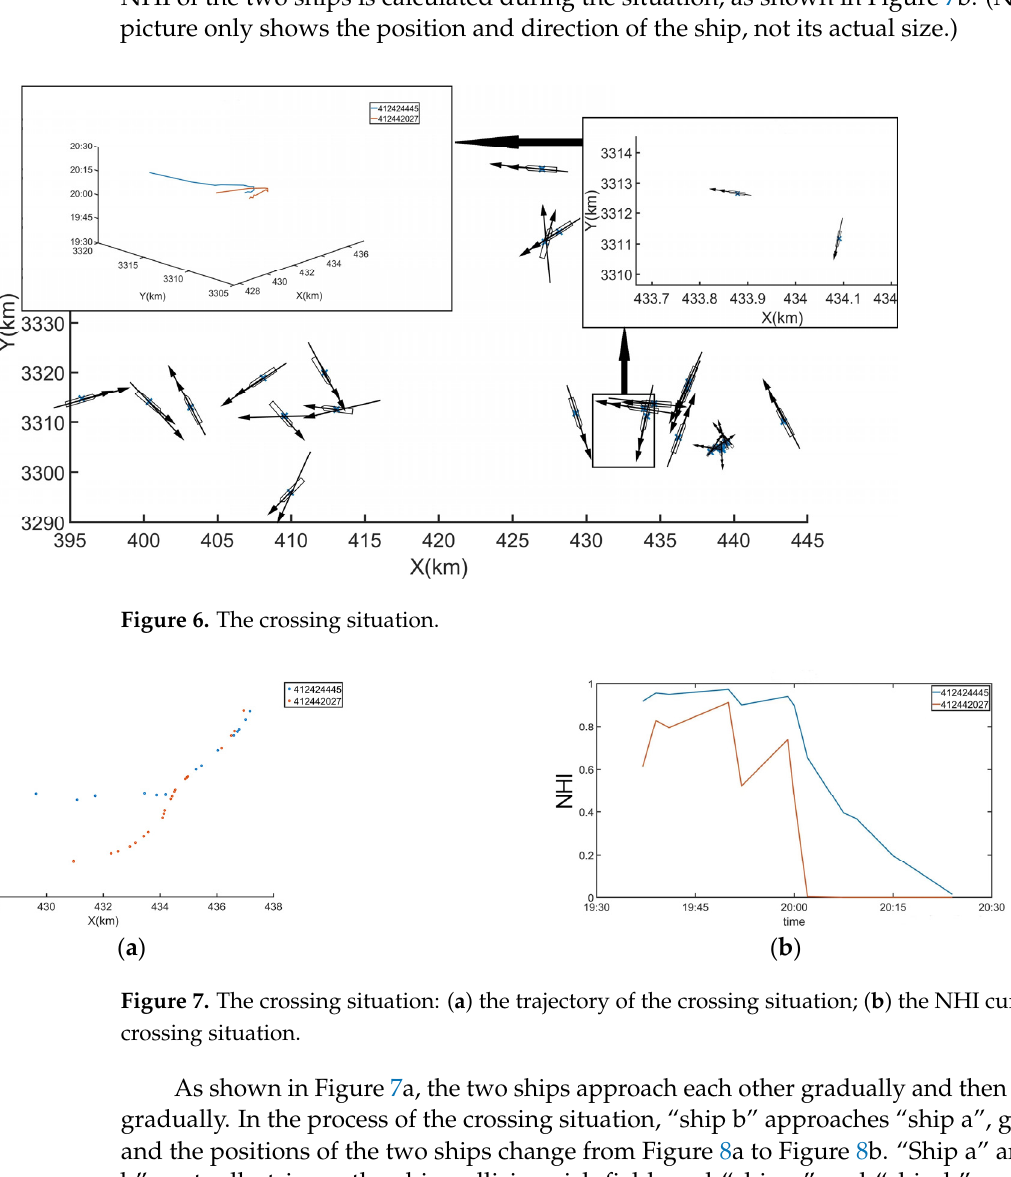
( b ) Figure 7. The crossing situation: ( a ) the trajectory of the crossing situation; ( b ) the NHI curve of the crossing situation.